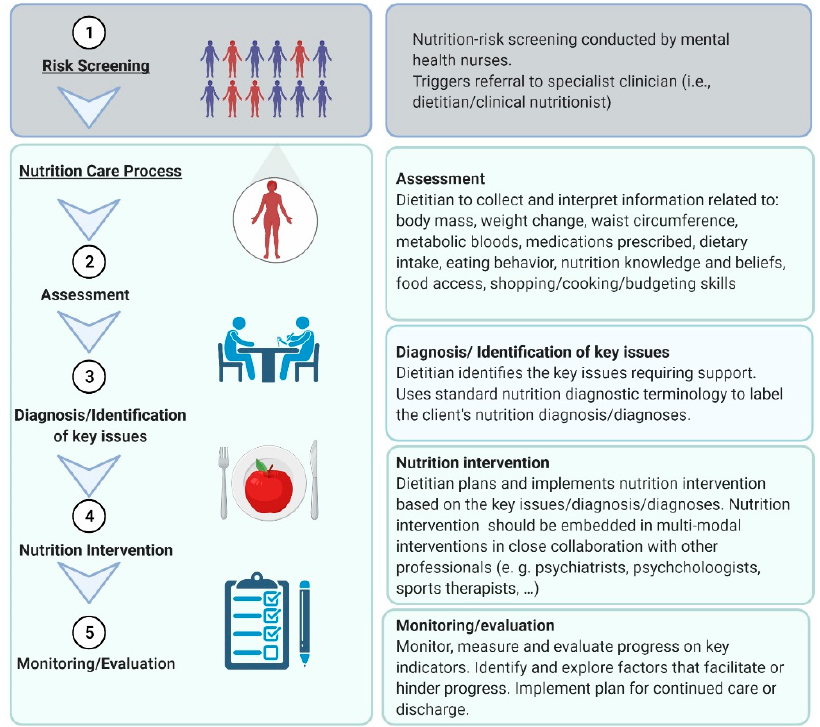
Figure 2. Identification and referral of patients at risk via the NutriMental Screening Tool. This figure was created with biorender.com (accessed on 7 October 2021)